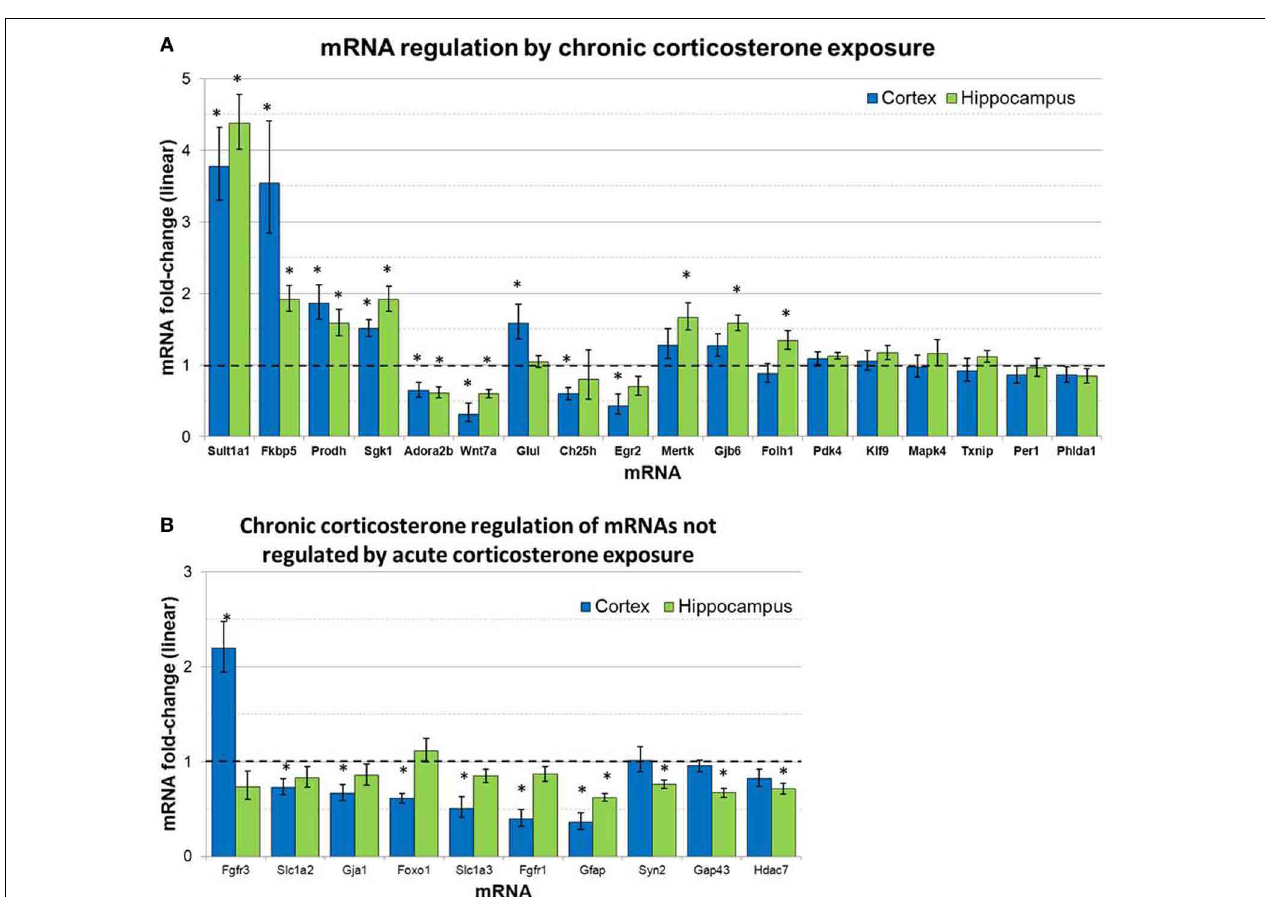
corticosterone-sensitive organs after chronic corticosterone administration. (C) Body weight of mice after chronic corticosterone ns = not significant.